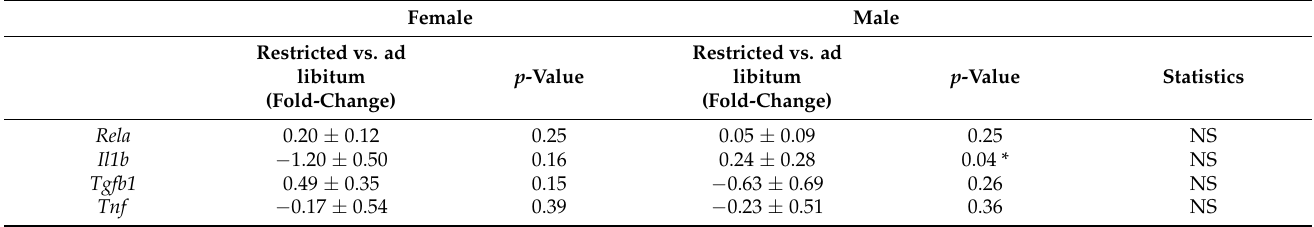
Table 9. mRNA expression levels of inflammatory markers. Two-way ANOVA was performed to assess for significance. NS: non-significant. * Statistical differences between calorie restricted and control groups. Rela: RELA proto-oncogen, nuclear factor kappa B subunit; Il1b: interleukin 1 beta; Tgfb1: transforming growth factor beta 1; Tnf: tumor necrosis